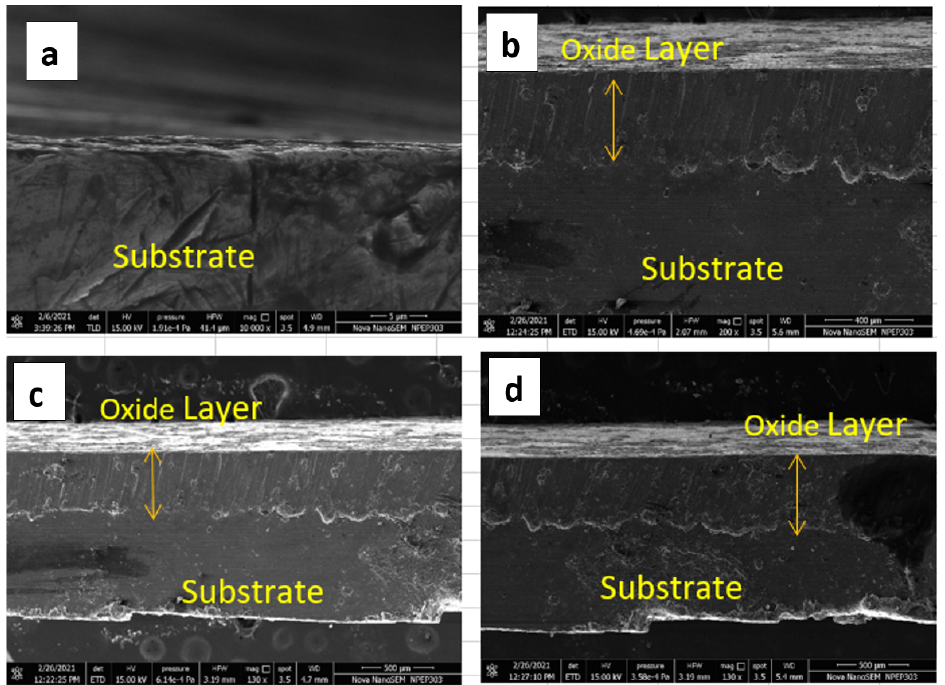
Figure 4: SEM images of Sample surfaces at a) Al 6061 (without oxide layer); b) at 150 V- and 5.5-Amp Current; c) At 180 V and 8.1 A d. 188 V and 4.5 A.